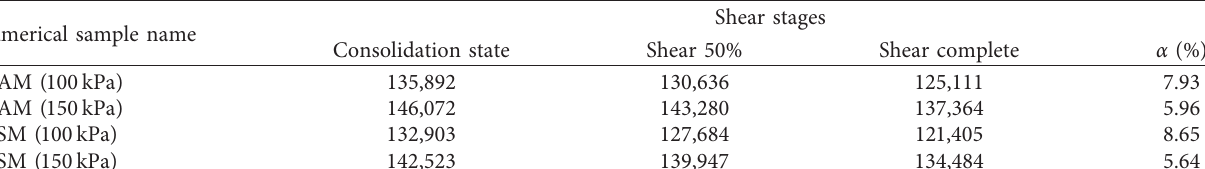
Table 3: Contact number in different shear stages.